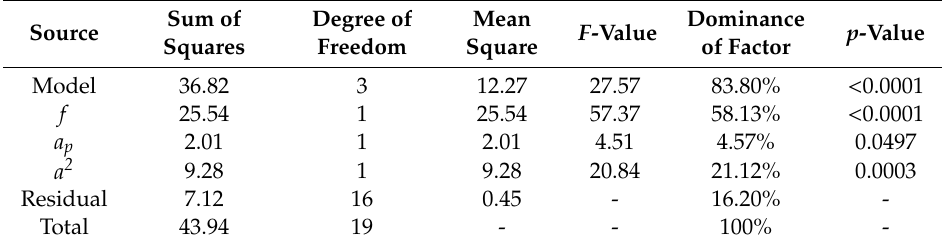
Table 9. ANOVA table for the maximum roughness height (Sz) after the backward elimination process. Dominance Sum of Degree of Mean p -Value F -Value Source of Factor Squares Freedom Square Model 36.82 3 12.27 27.57 83.80% < 0.0001 f 25.54 1 25.54 57.37 58.13% < 0.0001 a p 2.01 Residual 7.12 16 0.45 - 16.20% - Total 43.94 19 - - 100% -